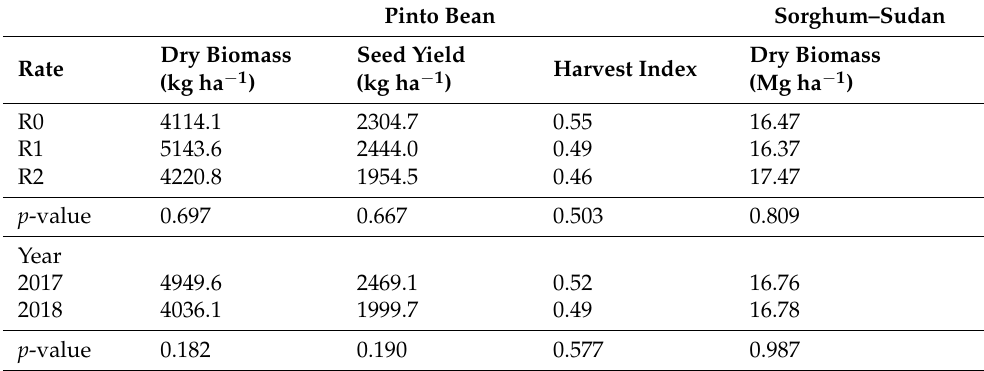
Table 2. Mean values of sorghum–Sudan dry biomass and pinto bean yield at different biochar rates and in different years. Pinto Bean